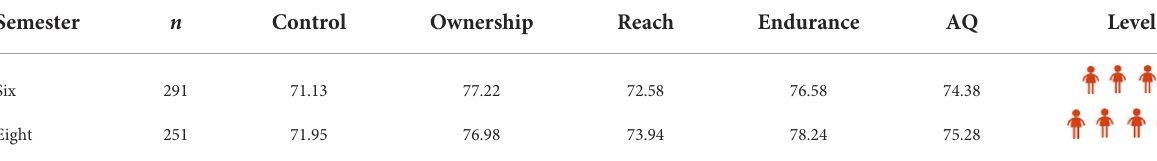
TABLE 12 AQ index values of practicum pre-service teachers by semester of study.